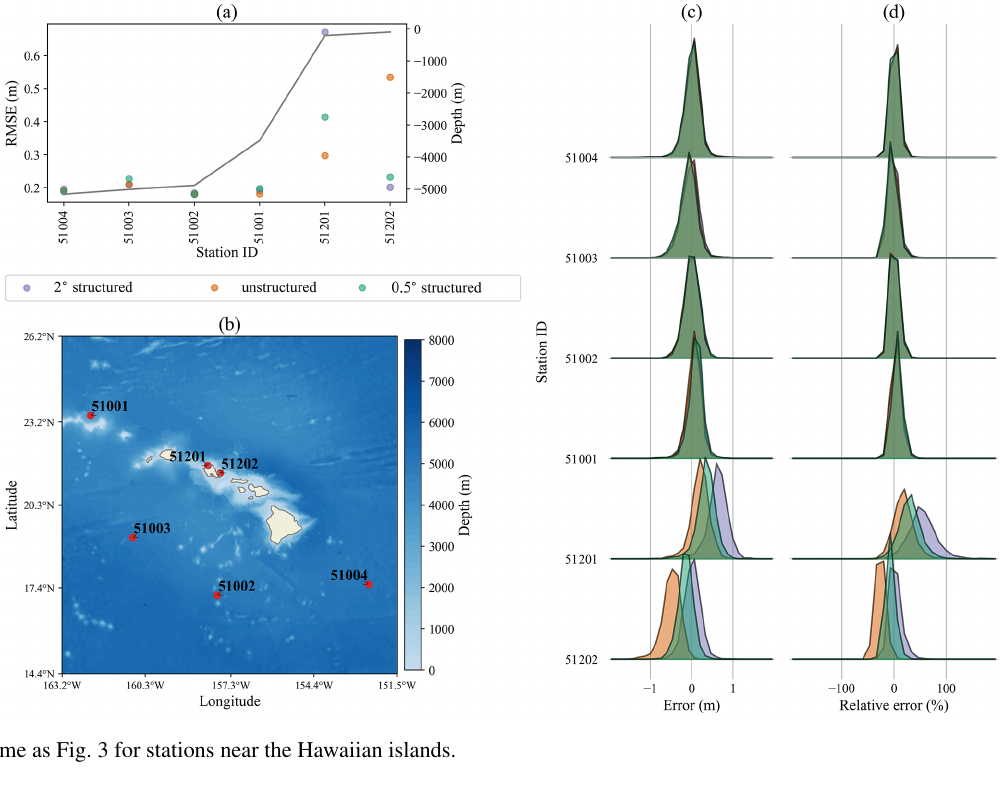
Figure 10. Same as Fig. 3 for stations near the Hawaiian islands.